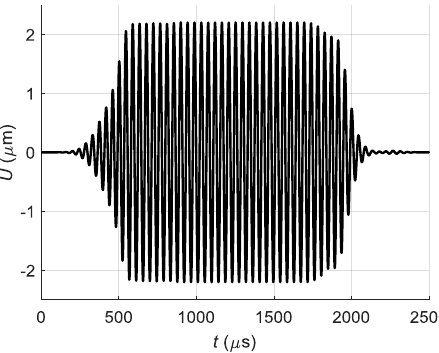
Figure 21. Spatial distribution of the maximum positive peak values of the acoustic pressure at the excitation zone when the corrected time delays between array elements were used.